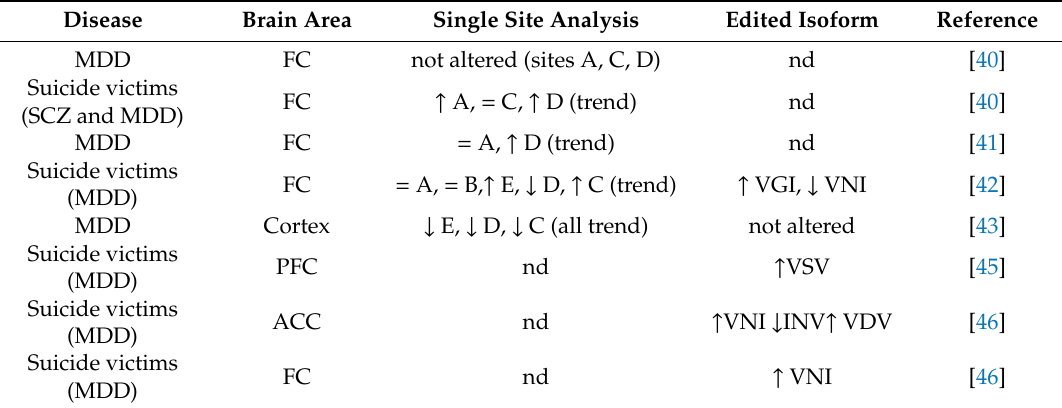
Table 1. 5-HT2c RNA editing status in the brains of patients with MDD and in suicide victims. Disease Brain Area Single Site